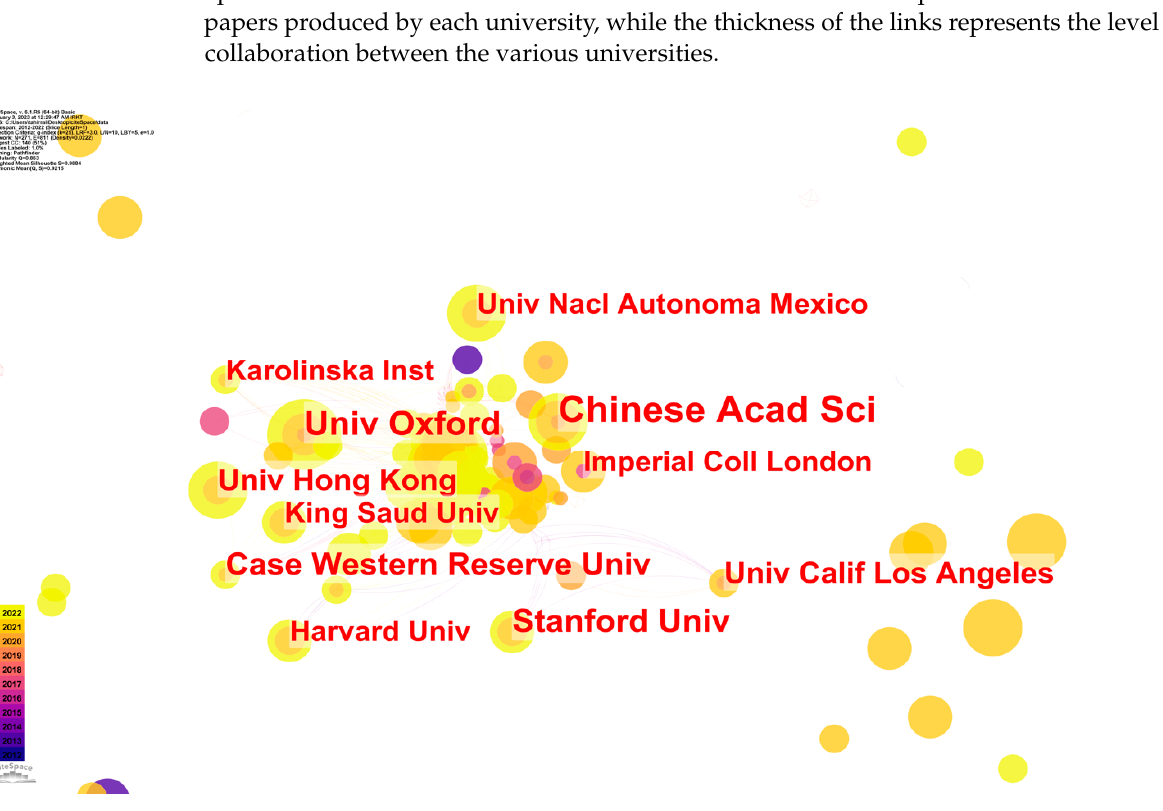
Figure 5. CS map of institution–co-authorship of studies on epidemic control based on big data research.